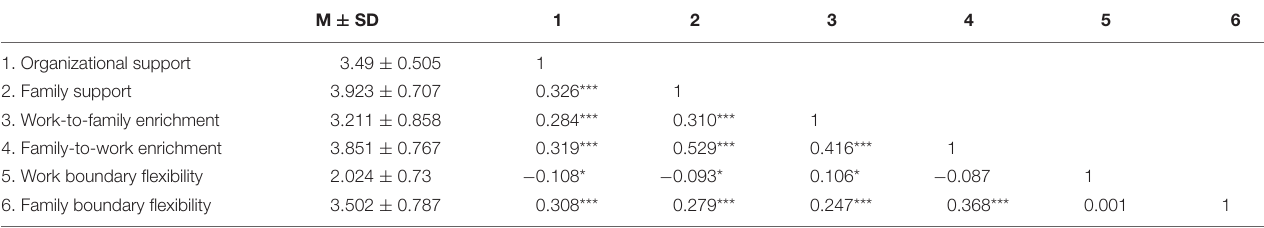
TABLE 2 | Descriptive statistics and correlation matrix of main research variables ( N = 504). M ± SD